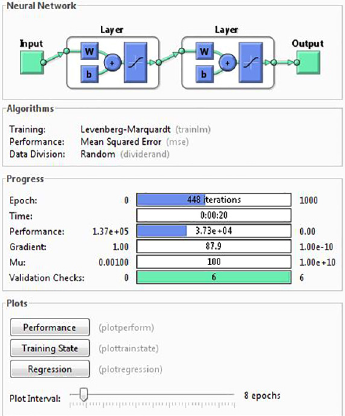
Figure 9. Trained Neural Network model g by the MATLAB